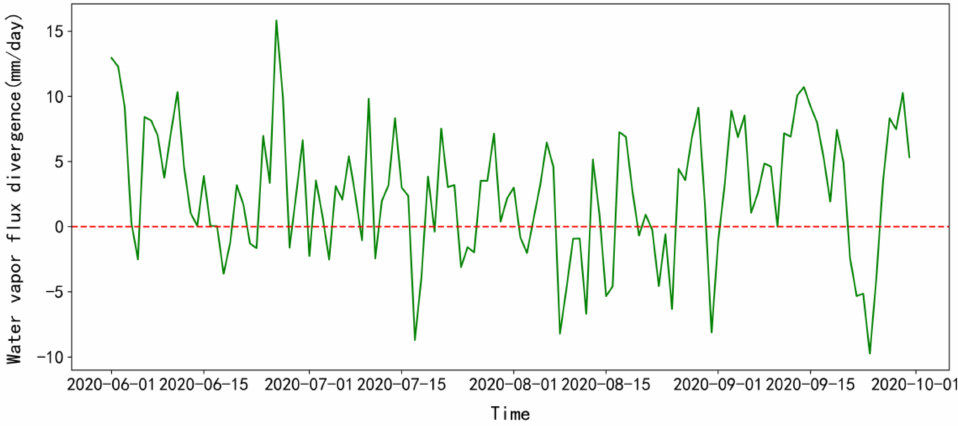
Figure 7. Daily moisture flux divergence during monsoon period in